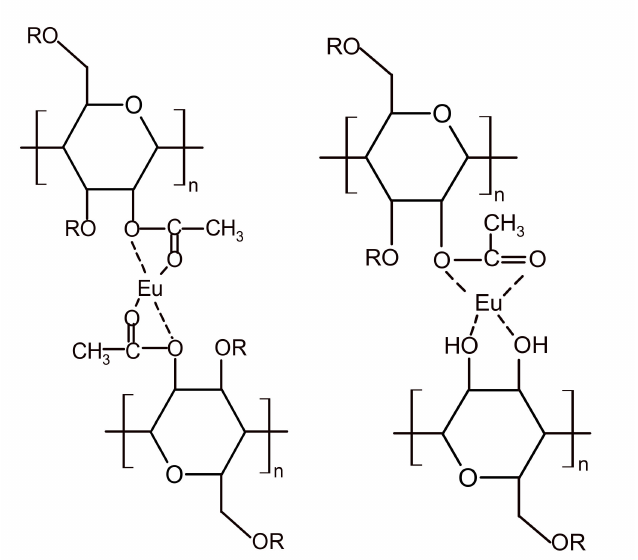
Figure 3. Schematic diagrams of the coordination structure between CA and Eu (III). (R = H or CH 3